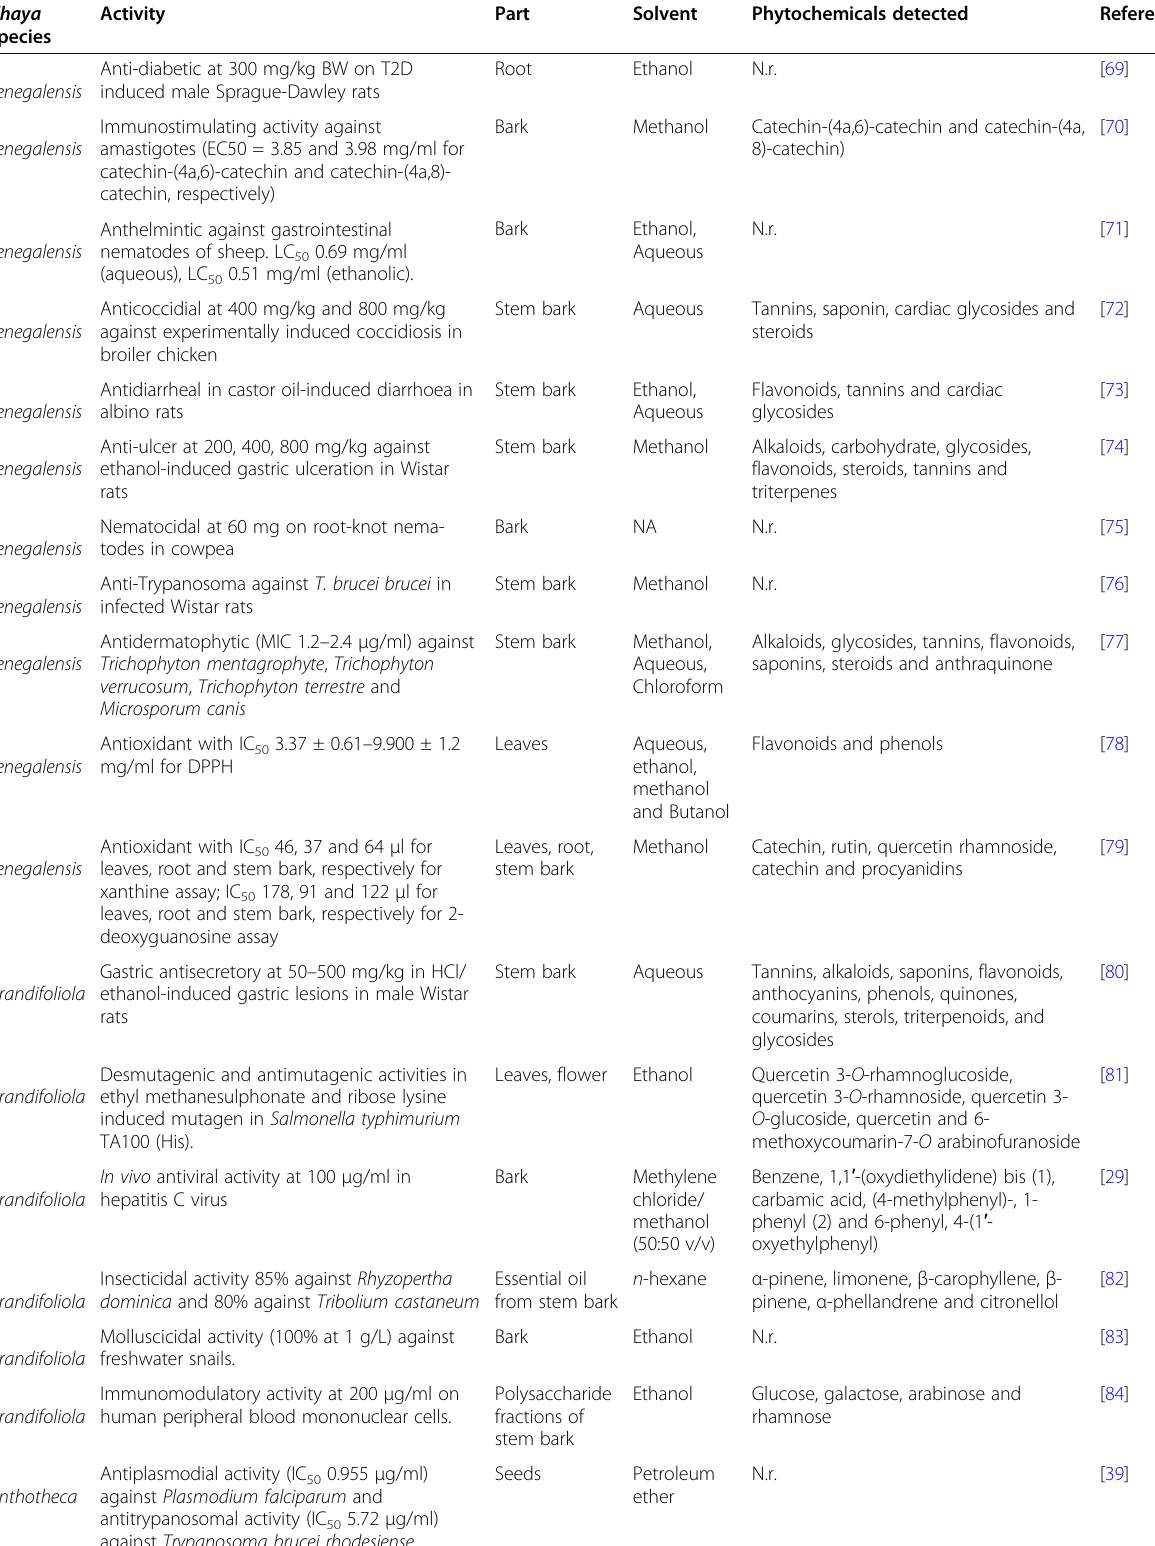
Table 2 Other (non-limonoid) reported bioactivities in the genus Khaya for the period 2000 –